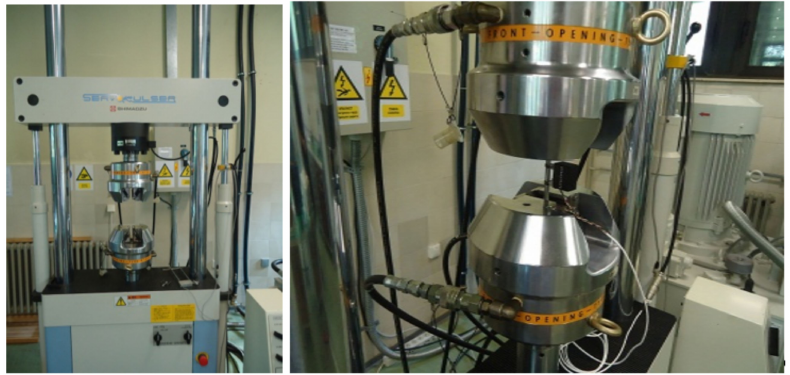
Figure 14. Test equipment configuration.